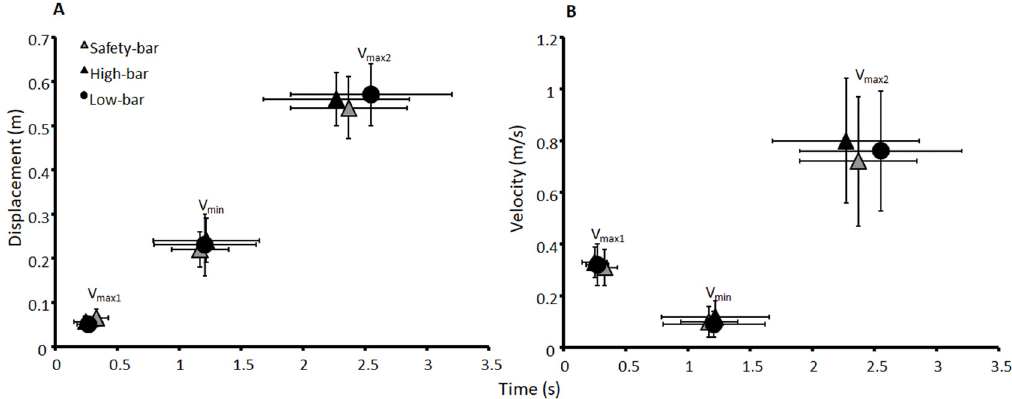
Figure 2. Mean ± standard deviation (SD) ( A ) displacement and ( B ) velocity at the events v max1 , v min , and v max2 , and their timings for the high-bar, low-bar, and safety-bar squat during 3-RM.